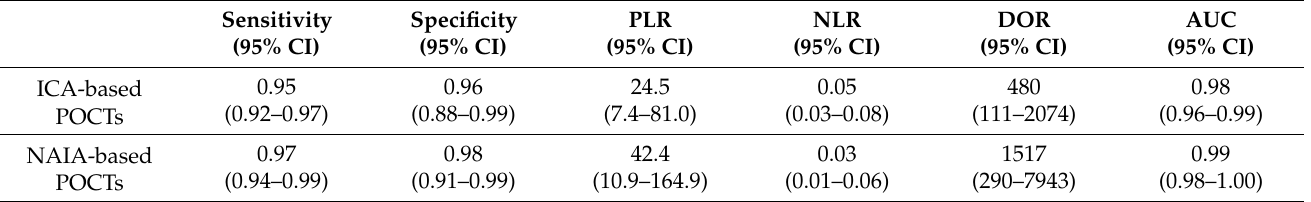
Figure 4. Summary receiver operating characteristic curves showing the pooled sensitivity and spec- ificity of ( A ) ICA- and ( B ) NAIA-based POCTs in diagnosis of PEDV.